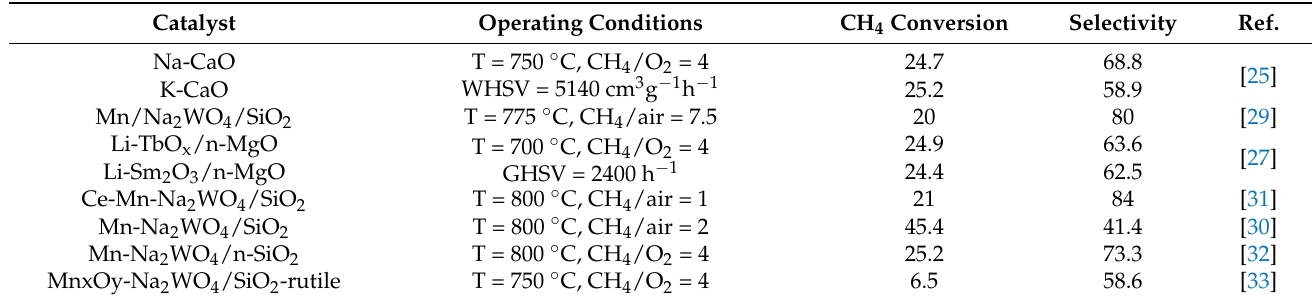
Table 1. Various catalysts used for the OCM